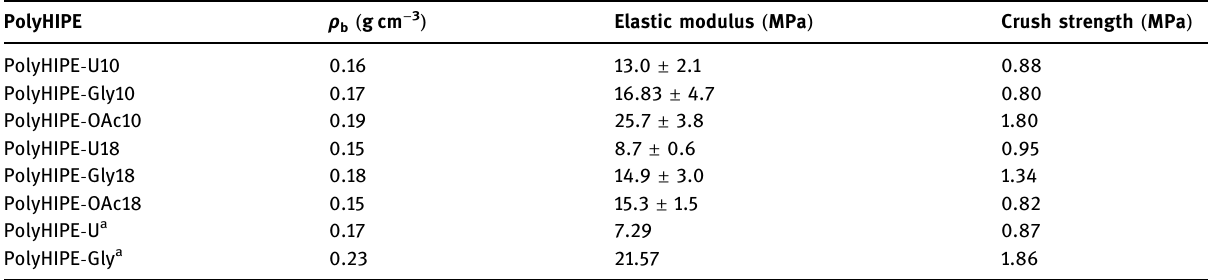
Table 2: Density and mechanical properties of polyHIPEs